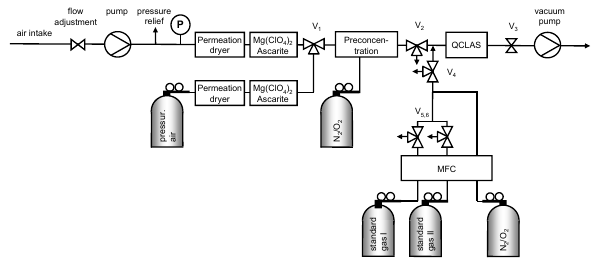
Fig. 1. Experimental setup for online N 2 O isotopomer analysis in ambient air. Vi are solenoid valves and MFC mass flow